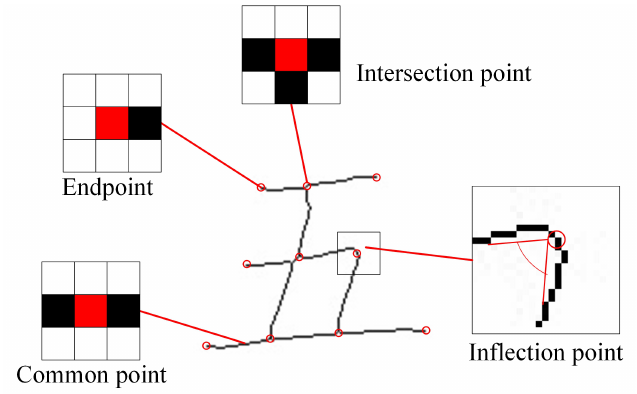
Figure 3. Different neighborhood features for different feature points.